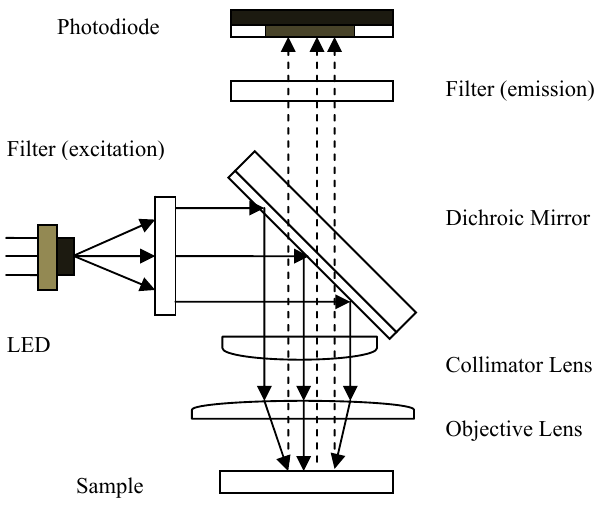
Figure 1. Structure of optical path in the